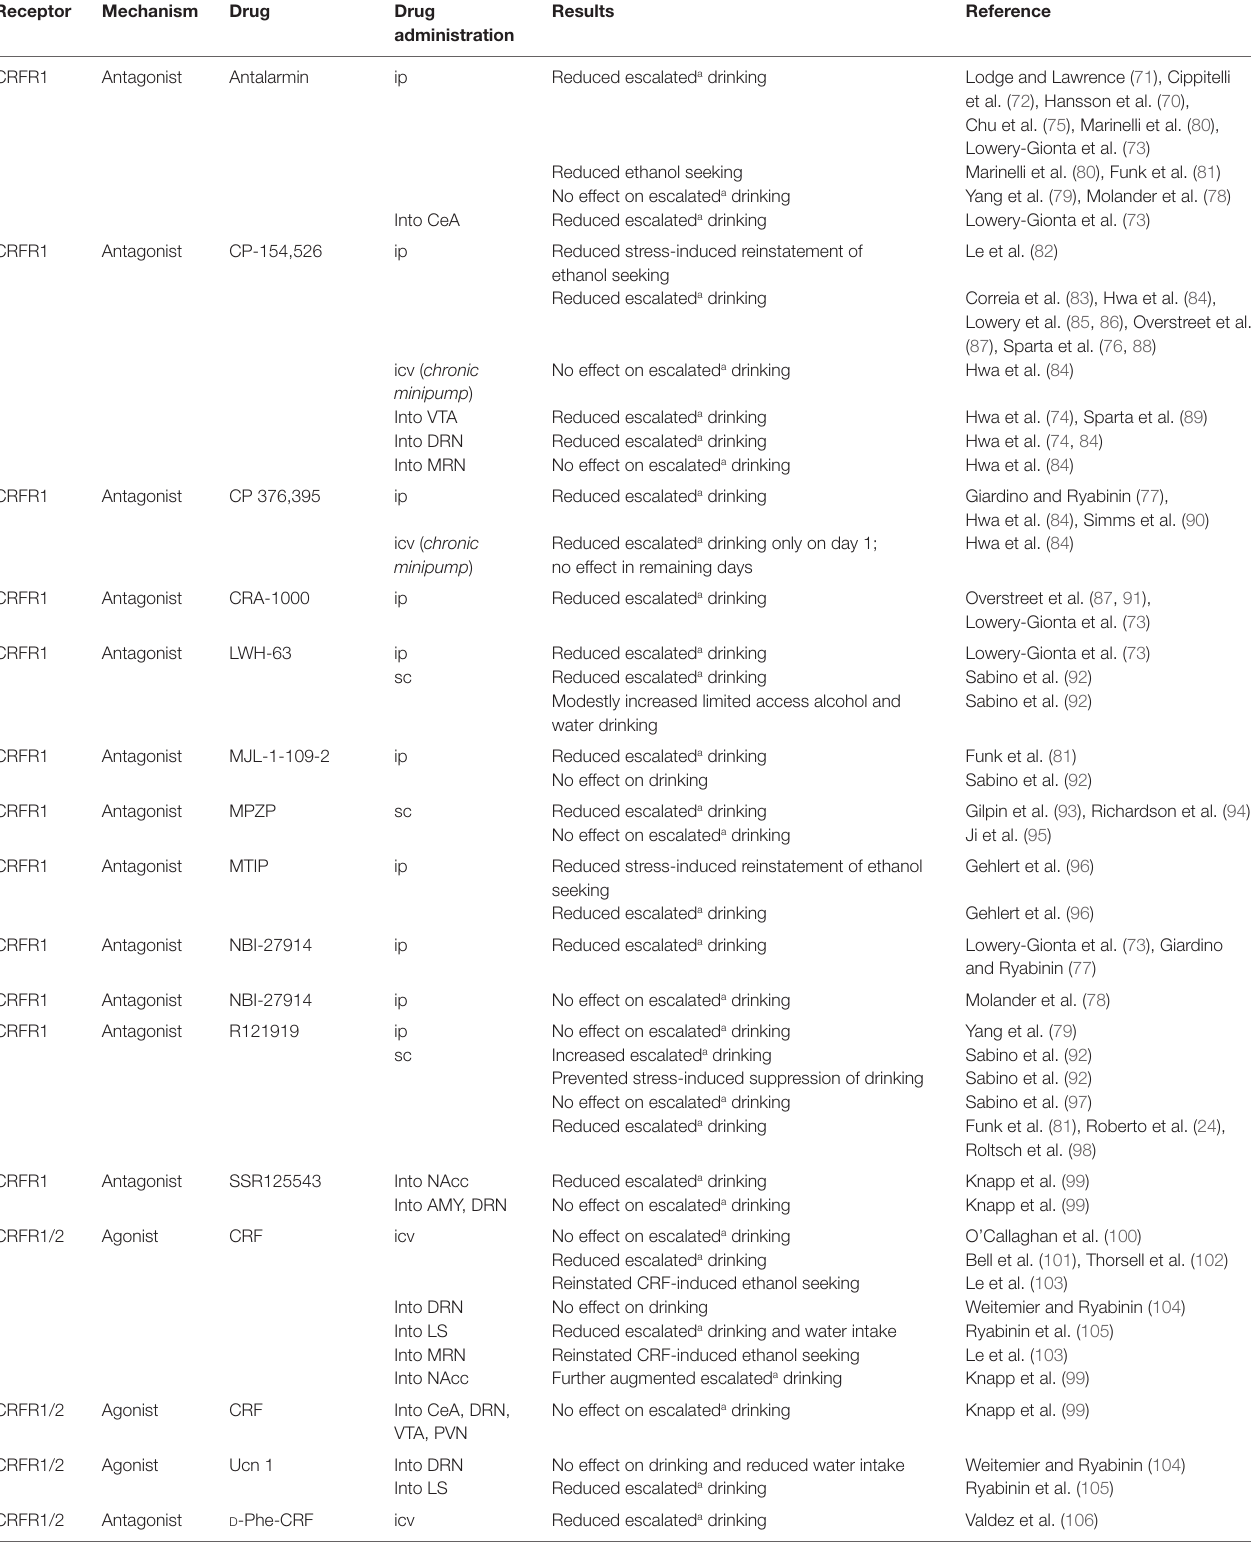
TABLe 1 | Summarized effects of pharmacological manipulations of CRF/urocortin targets on alcohol-drinking